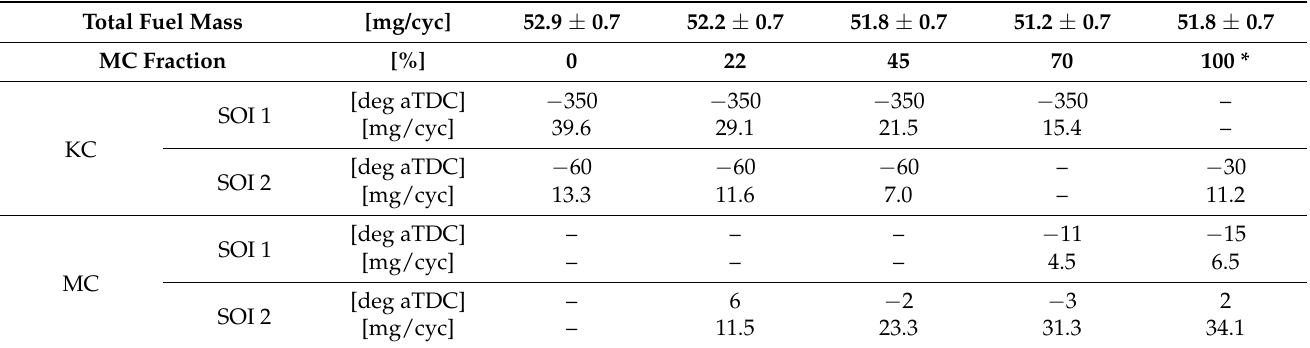
Table 5. Injection parameters for kinetically-controlled (KC) and mixing-controlled (MC) injections for the MC fraction sweep. * The injection at − 30 deg aTDC behaves kinetically, but functions as a pilot injection, which is typical for MC combustion.